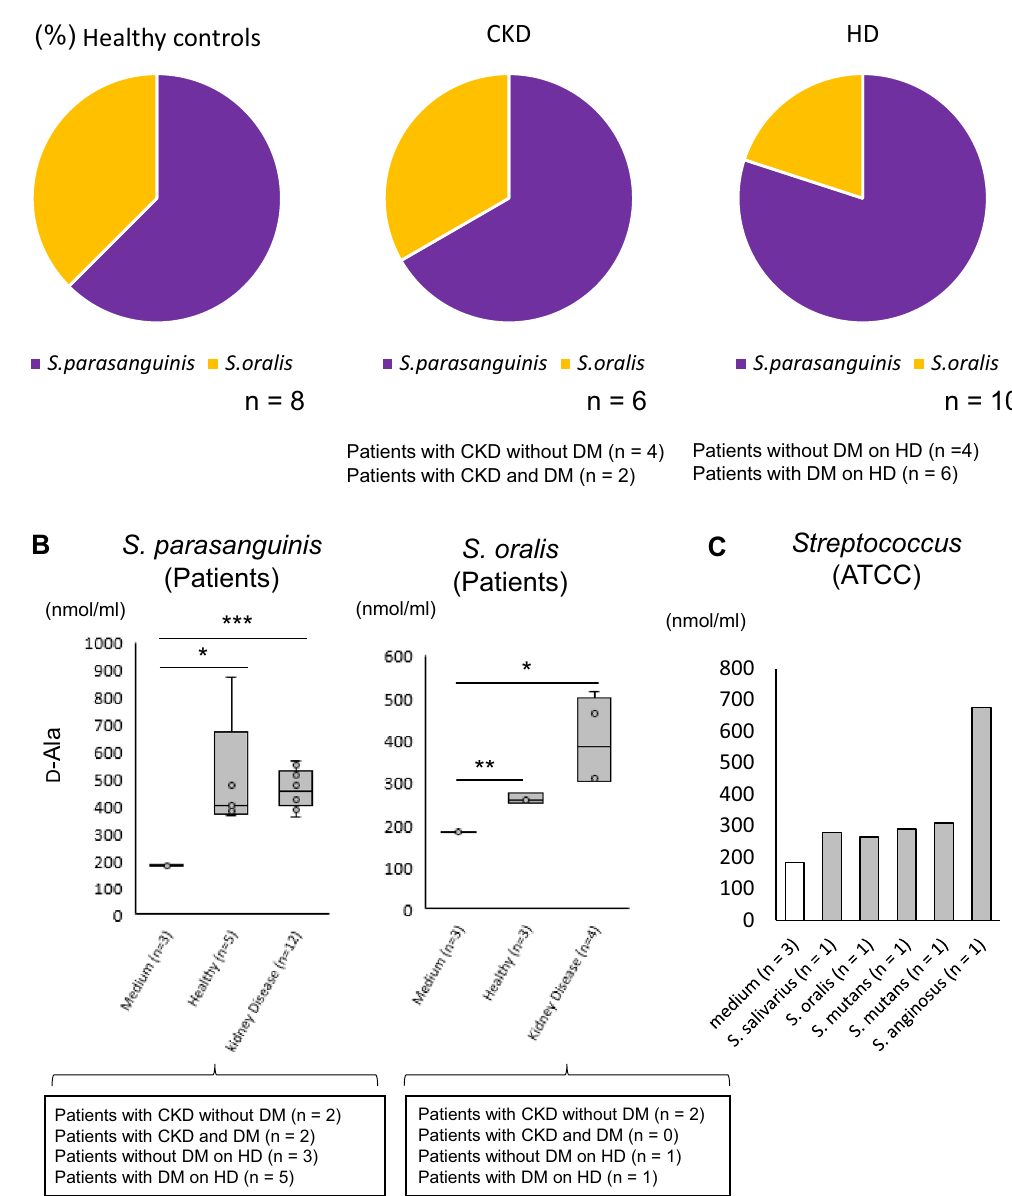
Figure 5. Association between oral Streptococcus species and d-alanine (D-Ala) levels. ( A ) Rates of isolation of Streptococcus species from saliva. ( B ) D-Ala levels in the culture supernatants of S. parasanguinis and S. oralis . ( C ) D-Ala levels in the culture supernatants of Streptococcus species from the American Type Culture Collection. * p < 0.05, ** p < 0.01, *** p < 0.001 (one-way ANOVA). CKD chronic kidney disease, DM diabetes mellitus, HD